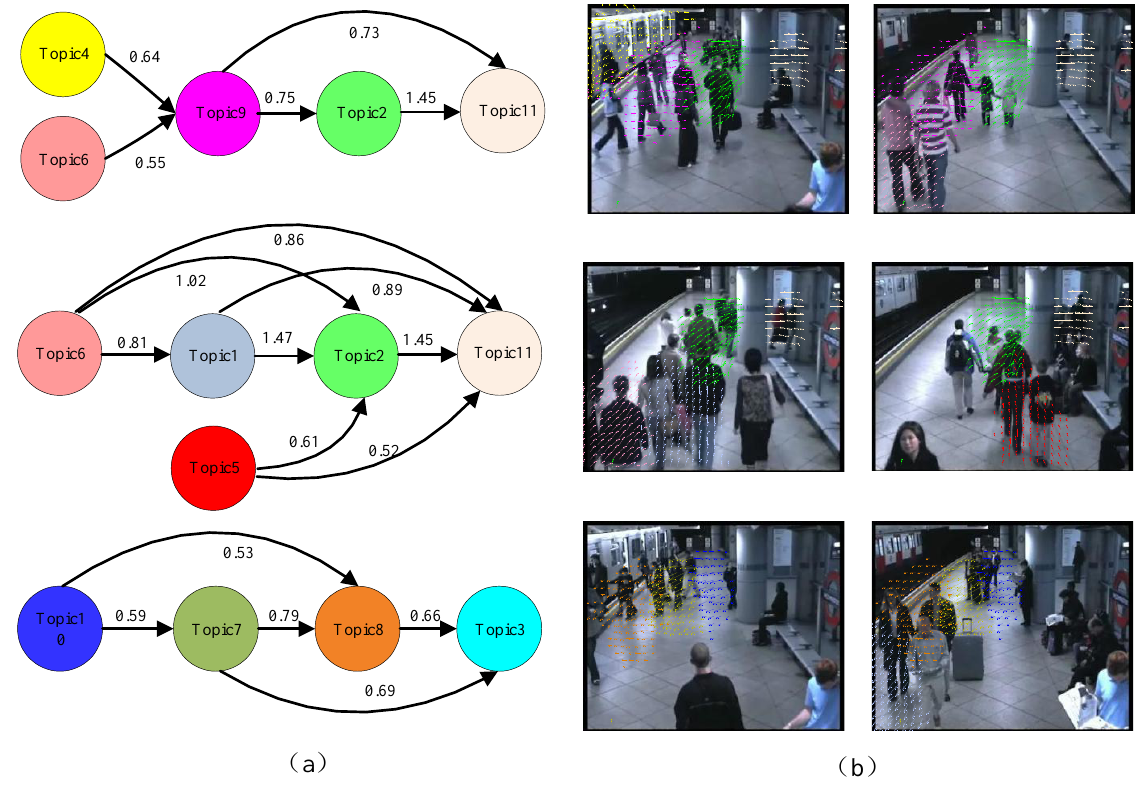
Figure 11. Granger causality approach applied to the subway dataset. ( a ) Left: visualization of the temporal causal analysis; ( b ) Right: six motion patterns are automatically